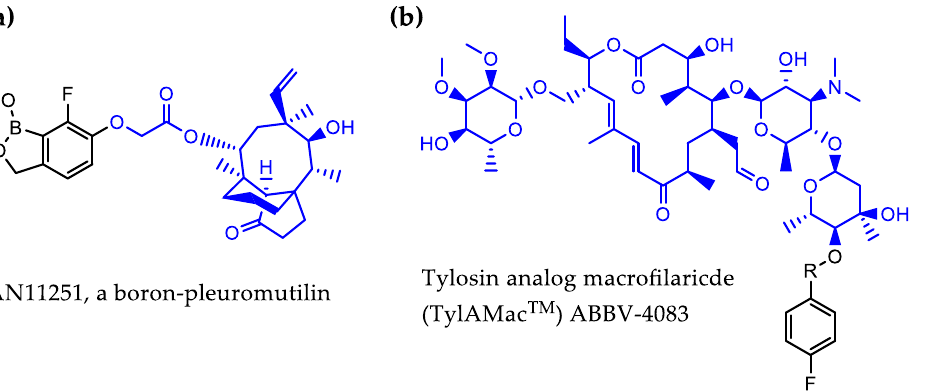
Figure 3. Structures of AN11251 ( a ) and the tylosin core of ABBV-4083 (TylAMac) ( b ). The antibiotic core of each molecule is colored blue. core of each molecule is colored